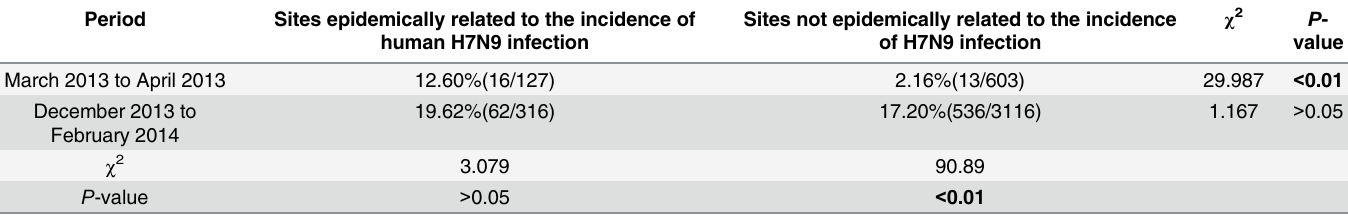
Table 3. A comparison of H7N9 virus prevalence in sites associated with human cases of H7N9 infection. Period